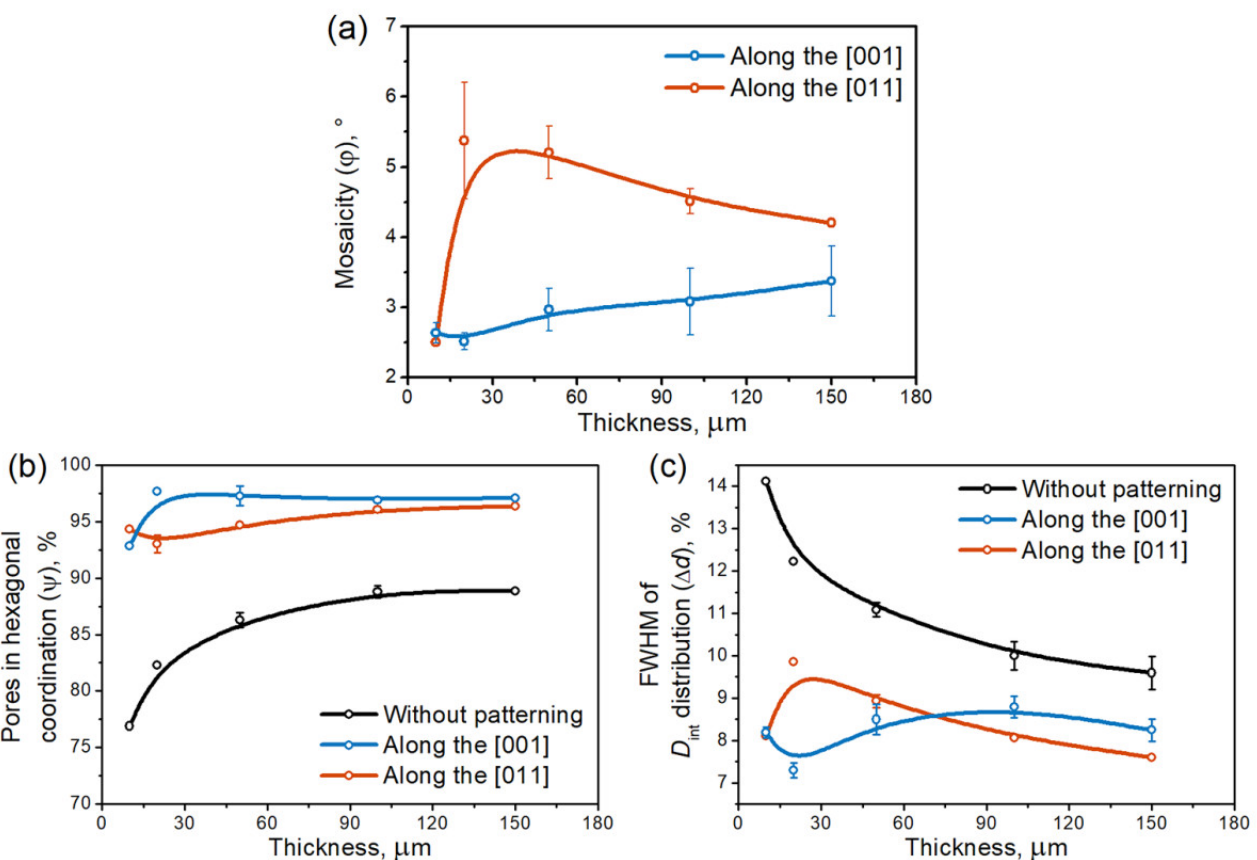
Figure 4. Thickness-dependent degree of pore ordering in AAO formed by anodization of pre-patterned Al(100) single crystal: ( a ) the mosaicity of porous structure, ( b ) the fraction of pores in hexagonal coordination, and ( c ) the FWHM of D int distribution. The error bars correspond to the standard deviation calculated from at least four SEM images, each containing around 5 × 10 4 pores. The B-spline curves are given to guide the eye.